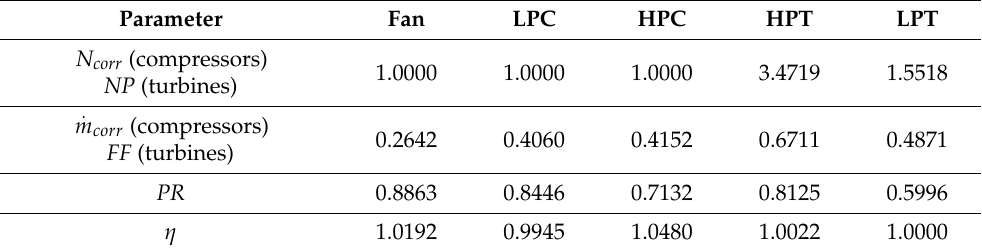
Table 8. Turbomachinery components scaling factors (dimensionless).